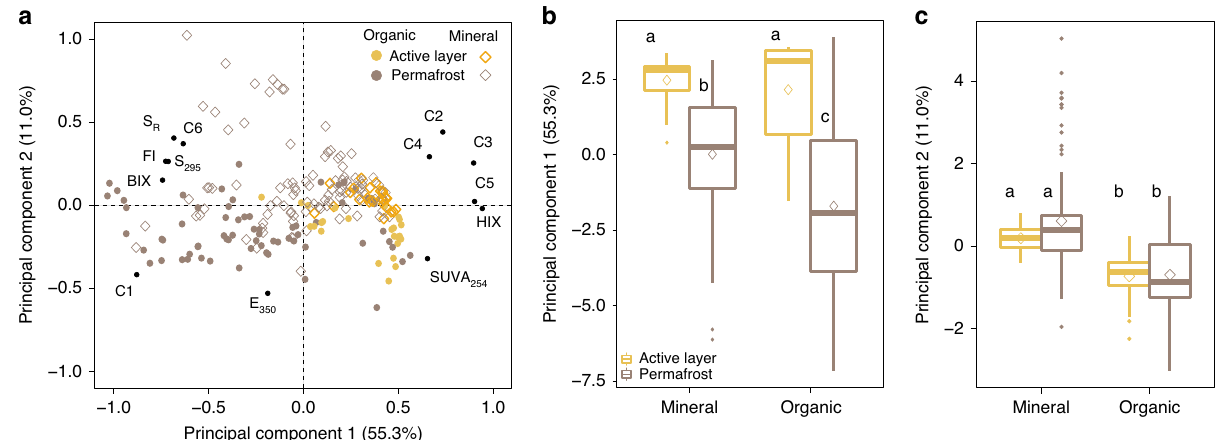
Fig. 4 Principal component analysis of DOM optical properties. The analyses takes into account the relative contribution of PARAFAC components and optical indices: the absorption coef fi cient at 350 (E 350 ), the speci fi c UV absorbance (SUVA 254 , L mg C − 1 m − 1 ), the absorption spectral slope over the spectral band 275 – 295 nm (S 295 ), the slope ratio between S 295 and the spectral slope over 350 – 400 nm (S R ), the fl uorescence index (FI), the freshness index (BIX), the humi fi cation index (HIX). a Explanatory variable loadings are shown as black dots and scores across the fi rst and second principal components for all samples labeled by layer type — organic layers are shown as circles and mineral as diamonds — and colored by location in the active layer or permafrost. b Box plot of the scores of the fi rst principal component for organic (soil C ≥ 12%) and mineral layers (soil C < 12%) in the active layer and in the permafrost. c Box plot of the scores of the second principal component for organic (soil C ≥ 12%) and mineral layers (soil C < 12%) in the active layer and in the permafrost. In each box plot, the diamond represents the mean, the horizontal line represents the median, the end of the box the 25 th and 75 th percentiles, and the lines extending from the box are 1.5 interquartile ranges from the median. Data points outside of the 1.5 interquartile ranges are represented as dots. Letters indicate signi fi cant differences between thermal layers and soil types indicated by Mann – Whitney U